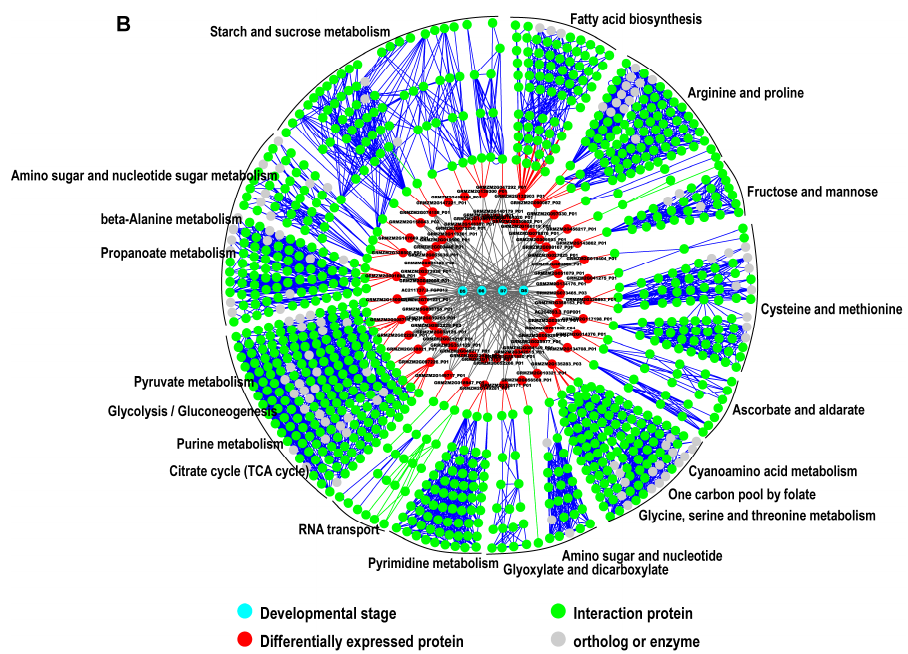
Figure 5. Interaction network of proteins identified by iTRAQ. The protein–protein interaction network of the differentially expressed proteins identified in this study was constructed using Kyoto Encyclopedia of Genes and Genomes (KEGG) database from the: pericarp ( A ); and endosperm ( B ), at 10, 20, 33 and 46 DAP. The interaction network was illustrated by Cytoscape software. In the network, the blue nodes represent the developmental stage, red nodes represent differentially expressed proteins identified in this study, green nodes display interaction proteins, and gray nodes represent annotated orthologs or enzymes from the KEGG database.